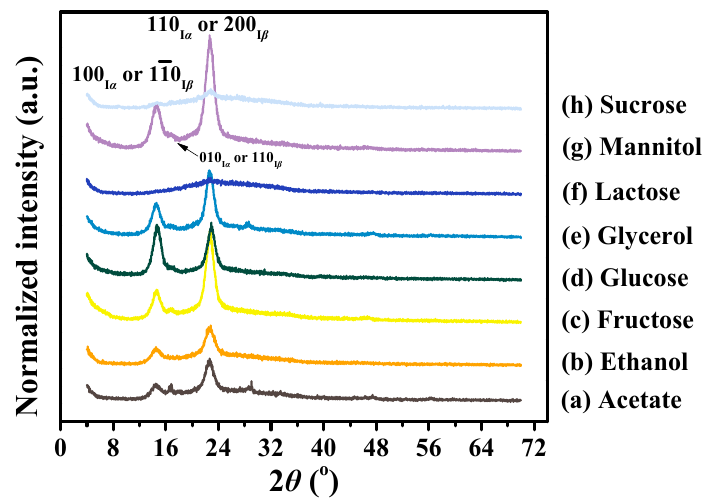
Figure 3. Comparative X-ray diffraction (XRD) analysis of the BC produced by Komagataeibacter sp. W1 grown in the media spiked with various carbon sources. The XRD pattern was obtained using nickel filtered copper K α radiation, with 0.1° steps, from 4° to 70° (2 θ ).